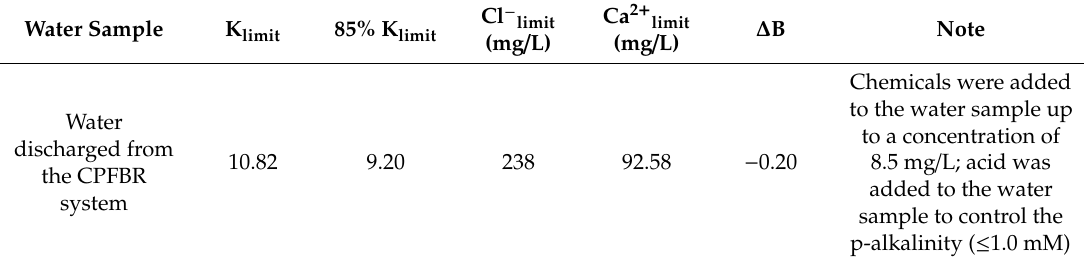
Table 3. The results of dynamic scale-inhibition test.